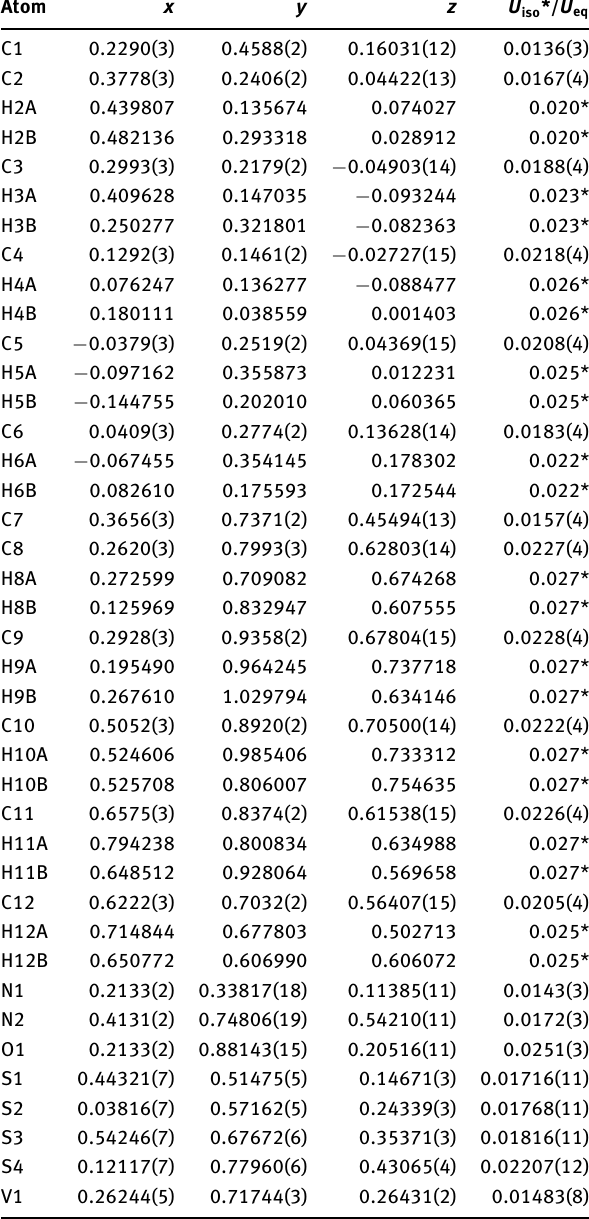
Table 2: Fractional atomic coordinates and isotropic or equivalent isotropic displacement parameters (Å 2